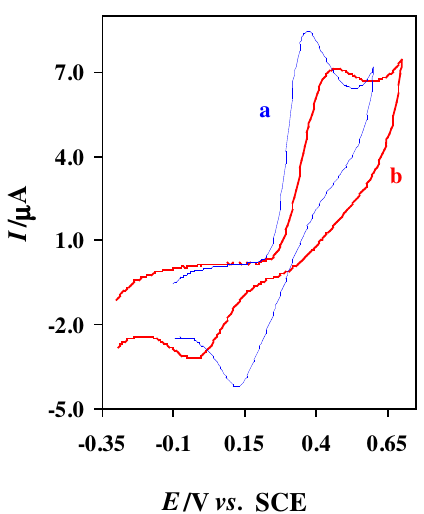
Figure 3. Cyclic voltammograms of thiourea at modified (curve a) and unmodified (curve b) Pt electrode in acetate buffer solution (C = 0.15 M, pH = 4.5). Scan rate, 50 mV/s. Thiourea concentration, 0.75